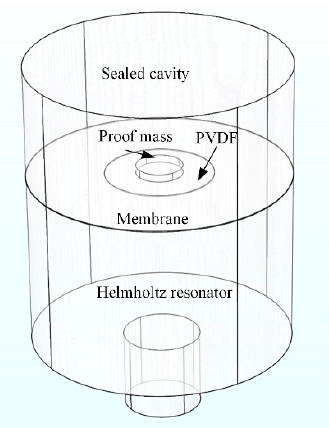
Figure 25. Schematic diagram of the proposed acoustic metamaterial.